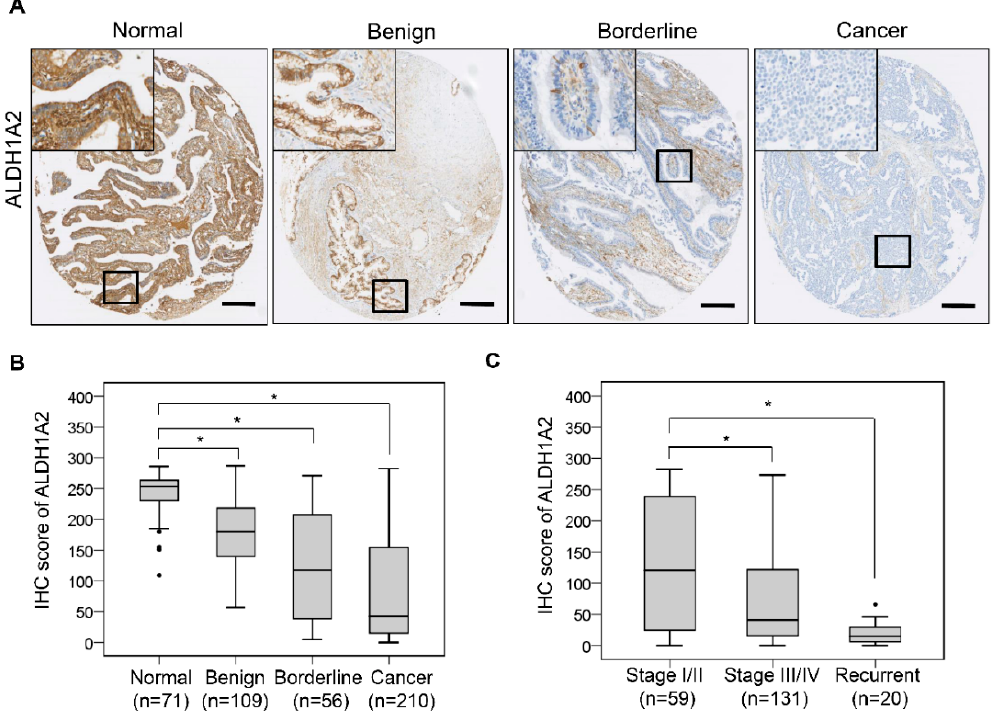
Figure 6. Reduced ALDH1A2 expression correlates with poor prognosis in ovarian cancer patients. ( A ) Representative images of immunohistochemical staining of ALDH1A2 expression in epithelial ovarian tissues from benign, borderline, and carcinoma patients and in nonadjacent normal tissues (Scale bar: 250 µ m). ( B,C ) Box plot depicting the immunohistochemical staining data. Histoscores were computed based on the intensity and tissue area of positive staining. * p < 0.001. Table 1. Expression of ALDH1A2 in relation to clinicopathological characteristics of ovarian cancer patients.